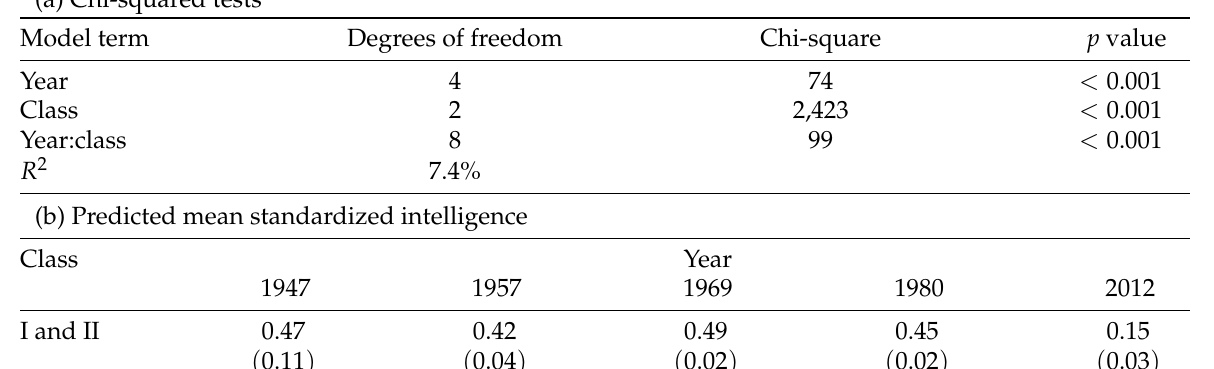
Table 2: Model of standardized intelligence in terms of year and class (a) Chi-squared